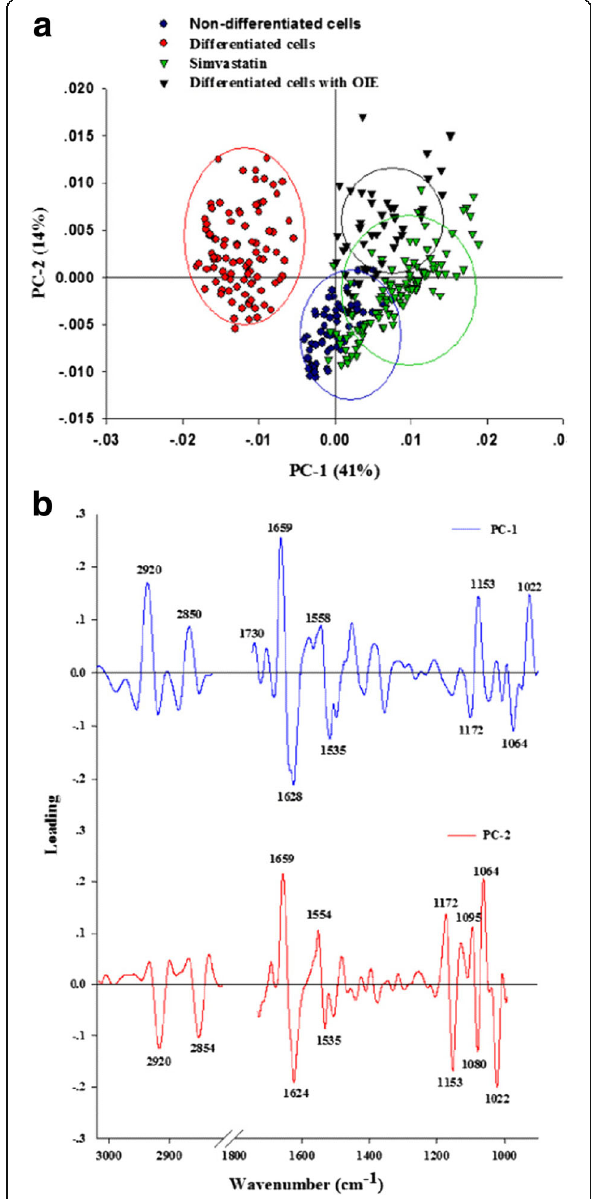
Fig. 8 Principal component analysis (PCA) of FTIR spectral ranges 3000 – 2800 cm − 1 and 1800 – 950 cm − 1 giving PCA score plot. The 2D PCA score plots showed the clustering separation spectra between 3T3-L1 non-differentiated cells, differentiated cells, simvastatin- and Oroxylum indicum extract-treated differentiated cells after 10 days ( a ). PCA loading plot ( b ). The biomarker differences over a spectral range of samples are identified by the PC1 and PC2 loading